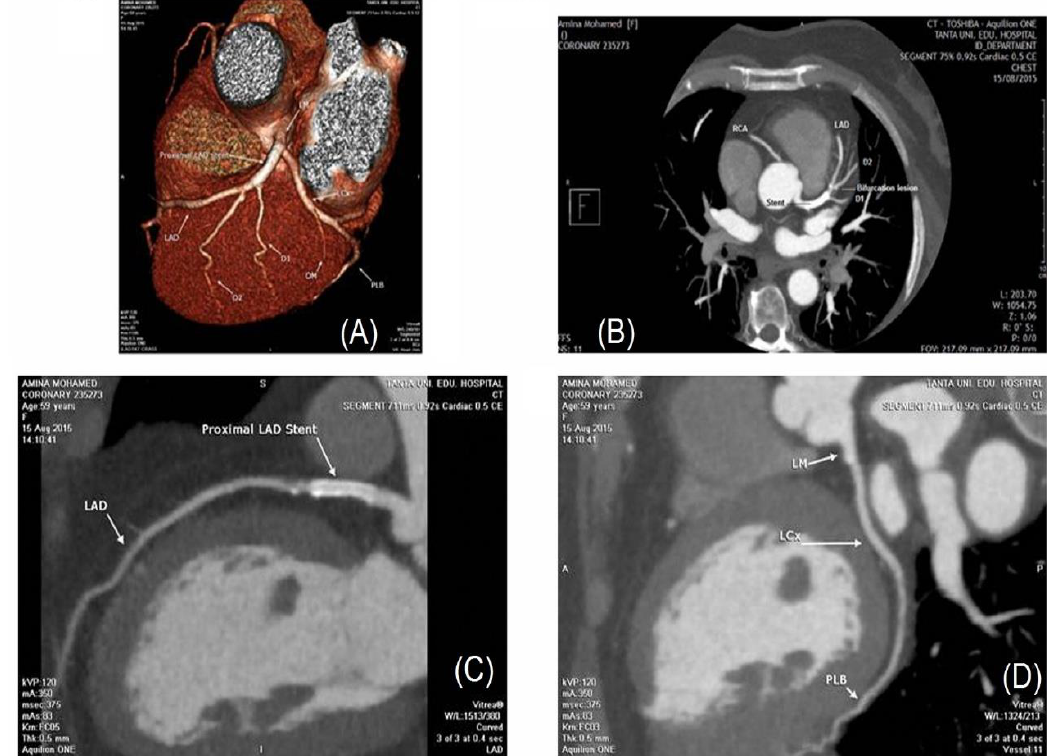
Figure 4. Computed tomographic (CT) angiography: ( A ) Left anterior oblique view of 3D volume rendered image showing the position of the proximal LAD stent; ( B ) Axial MIP image showing the position of proximal LAD stent; ( C ) Sagittal curved planar reformatted image showing patent proximal LAD stent; ( D ) Coronal curved planar reformatted image showing patent dominant LCx and PLB. Reproduced with permission [46], copyright 2020, Elsevier.